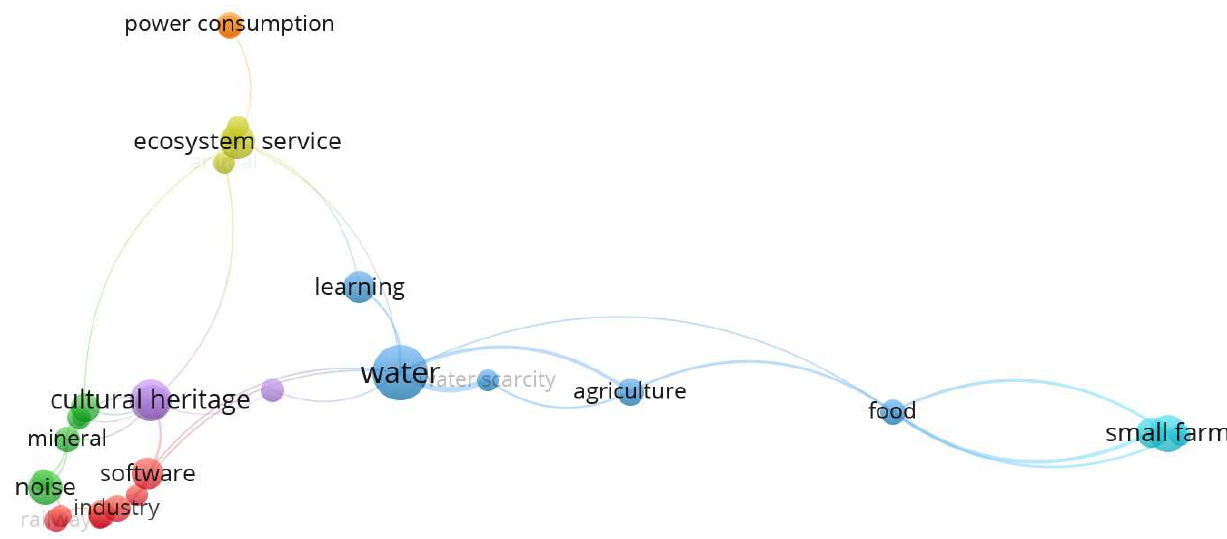
Figure 5. Network visualization of application fields. Table 4. Grouping the key terms into clusters.